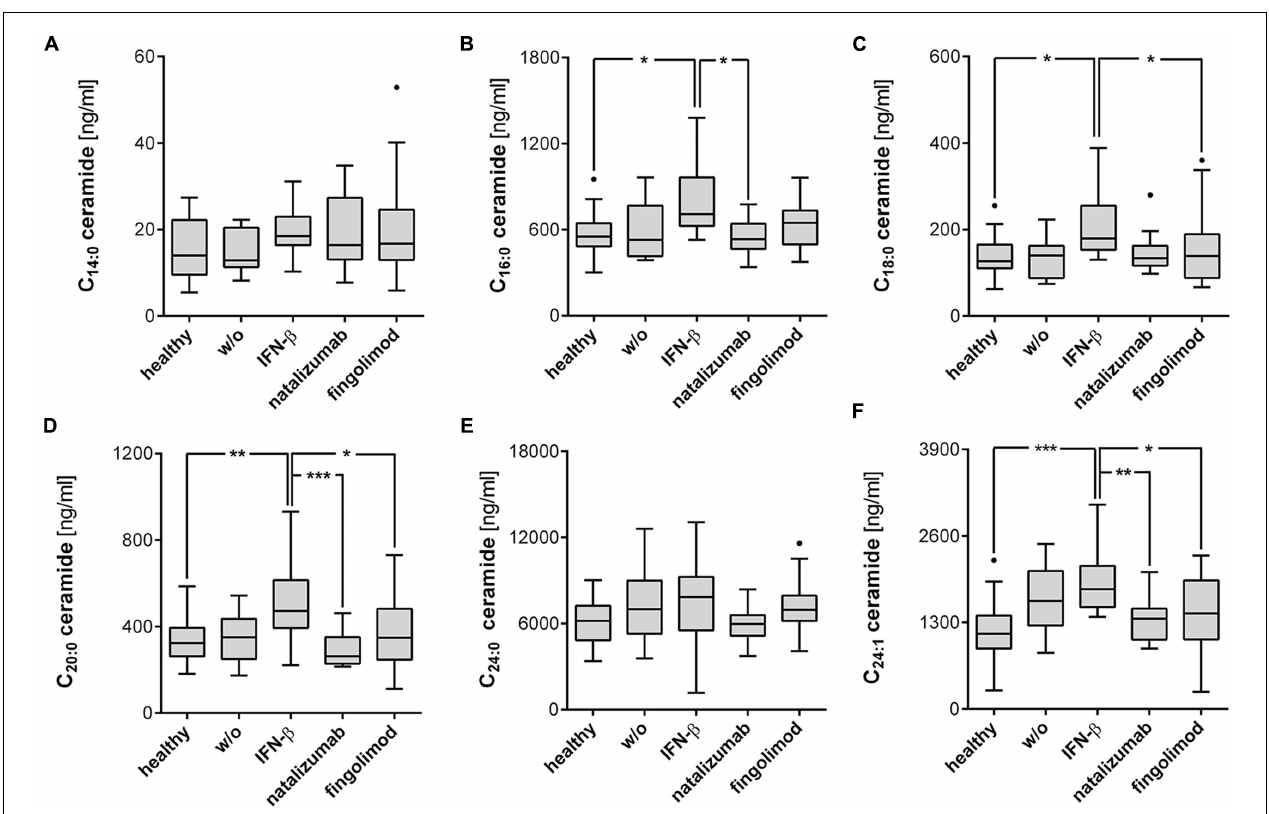
FIGURE 1 | IFN- β -treated RRMS patients demonstrated increased ceramides of specific chain length. (A–F) Ceramides were determined by mass spectrometry from plasma of RRMS patients and healthy controls. Data shown are Tukey box plots with a horizontal line representing the median, whiskers representing the 1.5 × interquartile range and dots representing outliers. Healthy controls ( n = 21), untreated patients (w/o, n = 11), IFN- β ( n = 18), natalizumab ( n = 16), and fingolimod ( n = 24) treated patients. One-Way ANOVA with Tukey’s post hoc comparison or Kruskal-Wallis’ test with Dunn’s post hoc comparison for normally or non-normally distributed data, respectively. ∗ p ≤ 0.05; ∗∗ p < 0.01; ∗∗∗ p <